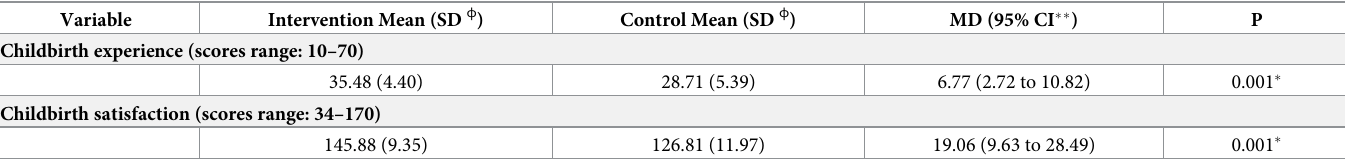
Table 3. The comparison of mean score of childbirth experience and satisfaction in the intervention and control groups after the intervention.